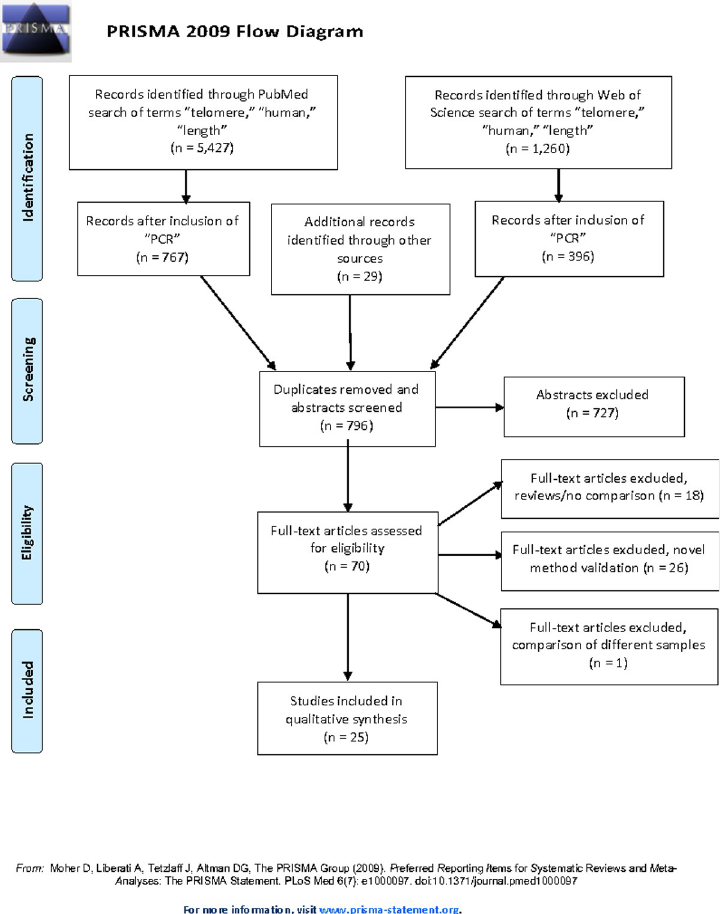
Fig 3. PRISMA flow diagram of literature search and article selection for inclusion. Date range searched was between Jan 1 2002 to May 10 2020. Other sources of article identification included suggestions from participants of the TRN and review of reference lists of selected